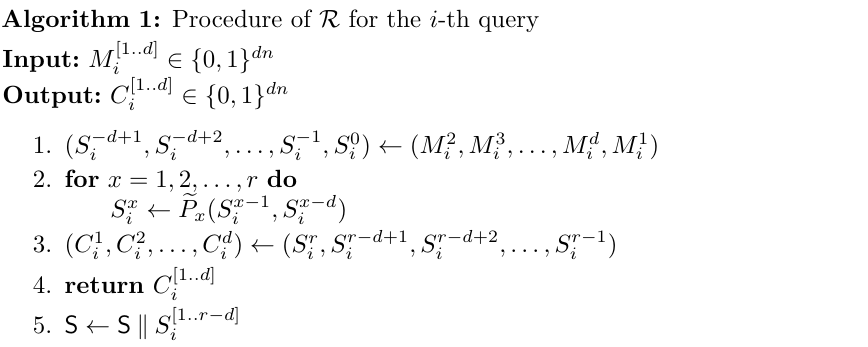
Algorithm 1: Procedure of R for the i -th query